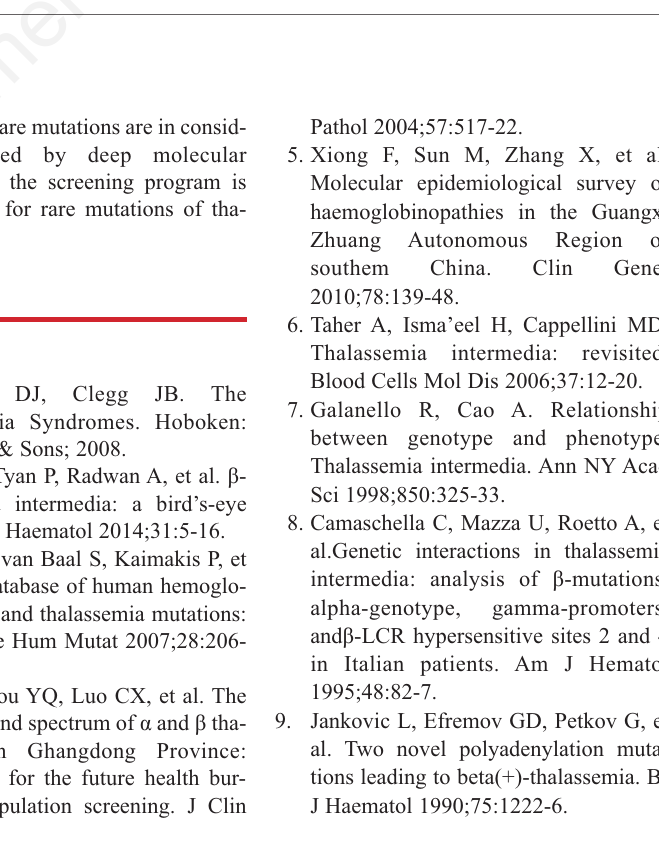
Figure 2. Detection of poly A (A 〉 G) mutation via DNA sequencing. A) Proband, B) Grandmother, C) Grandfather, D) Mother, E) Father, F)